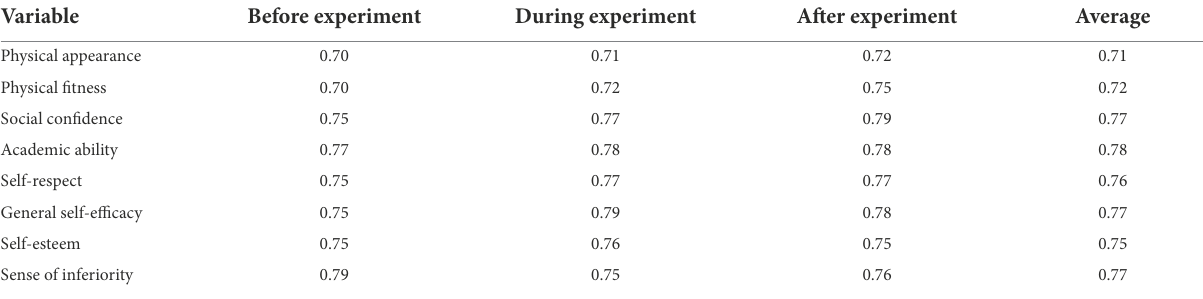
TABLE 4 Reliability test results of each submeter.